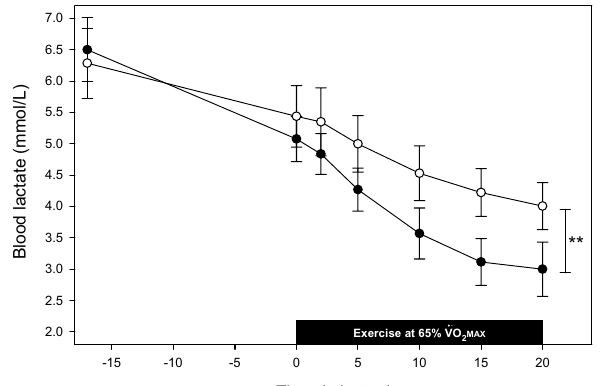
Figure 2. Blood lactate following volitional fatigue and during submaximal exercise at first study visit. Data for ID participants appear as white circles; those for IR participants, black circles. The initial venous lactate value was measured at volitional fatigue during the preceding maximal CPET. Following a 15-min interval, participants returned to the ergometer and measurements were made during two minutes seated at rest. The solid black bar indicates the period of submaximal exercise. A single lactate value was missing for one ID participant at the 2-min timepoint due to a technical issue. Values are means; error bars show SE. **, P = 0.005 for interaction of iron status and